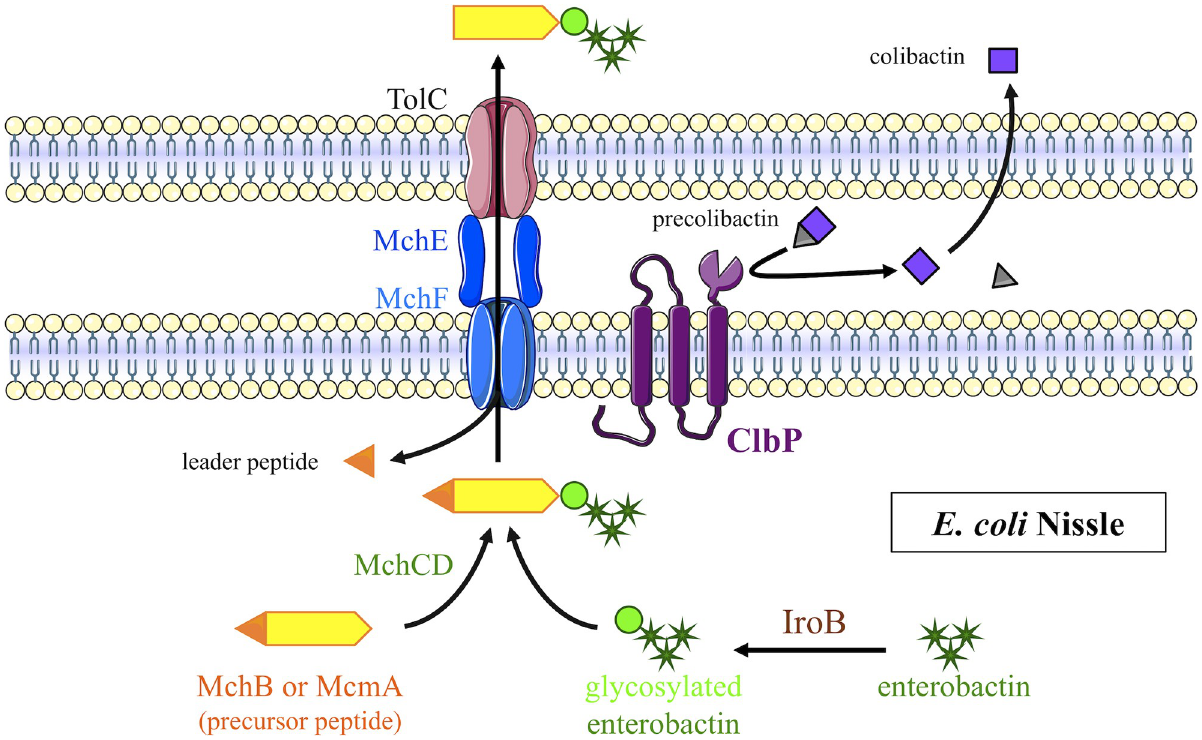
Fig 9. Model proposed for biosynthesis of siderophore-microcins H47 and M in E . coli Nissle. An enterobactin precursor is modified by the enterobactin glucosyltransferase IroB. This siderophore moiety is transferred onto the C-terminal extremity of the precursor peptide by the MchCD complex. The active form of the siderophore-microcin is the result of the leader peptide cleavage during its export by the specific efflux pump MchEF-TolC. The C-terminal transmembrane domain of ClbP allows this final step of siderophore-microcin production, while its N-terminal enzymatic domain cleaves precolibactin to produce